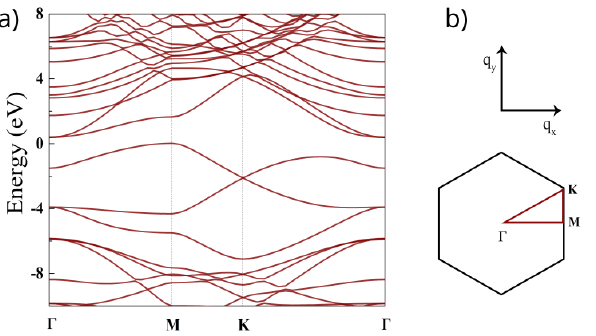
Figure 2. ( a ) DFT band structure calculations for C 3 N along the Γ − K − M − Γ line in the BZ. ( b ) orientation of the BZ and the high-symmetry points Γ , K , M